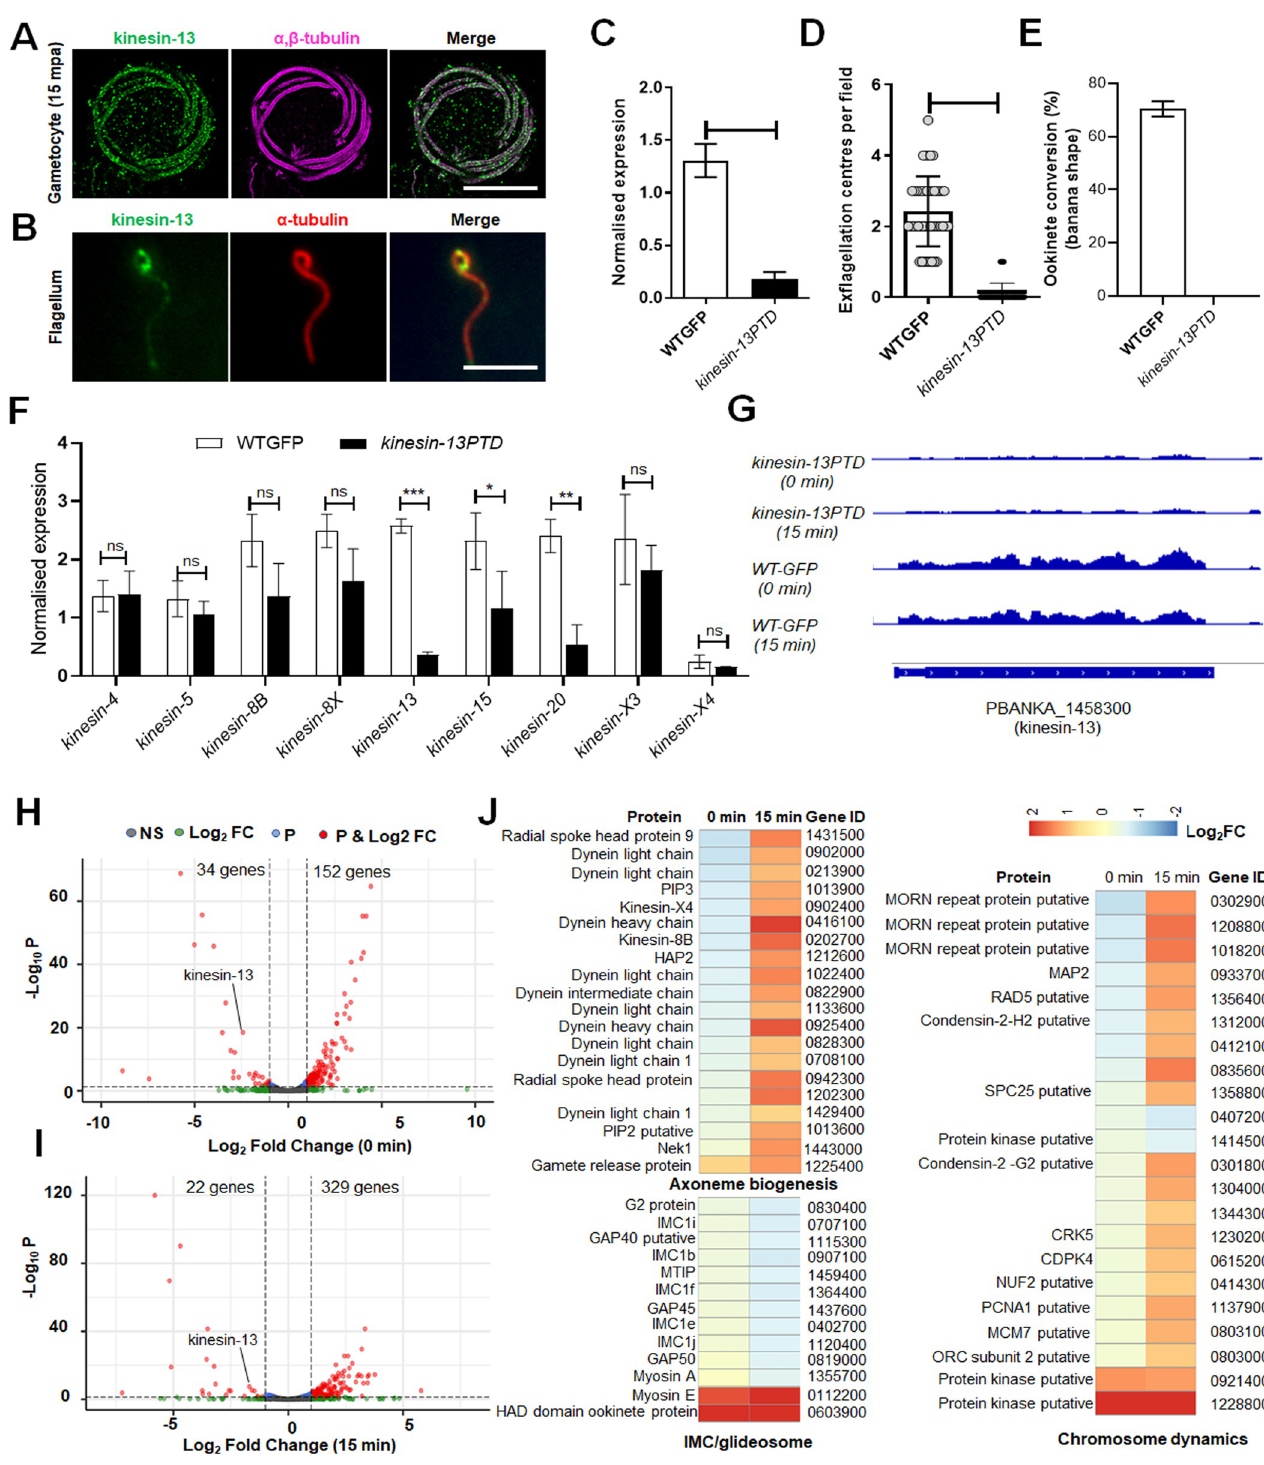
Fig 6. Kinesin-13 associates with axonemes in male gametocytes and gametes and its knockdown affects male gamete formation. (A) Expansion microscopy showing colocalisation of kinesin-13 (green) with α / β tubulin staining (purple) in gametocytes activated for 15 min. Scale bar = 5 μ m. (B) Indirect immunofluorescence assay showing the colocalisation of kinesin-13 (green) and tubulin (red) staining in male gamete. Scale bar = 5 μ m. (C) qRT-PCR analysis showing down-regulation of kinesin-13 gene in kinesin-13PTD parasites compared to WTGFP. Mean ± SEM, n = 3 independent experiments. (D) Exflagellation centres per field at 15 mpa. n = 3 independent experiments ( > 20 fields per experiment). Error bar, ± SEM. (E) Percentage ookinete conversion